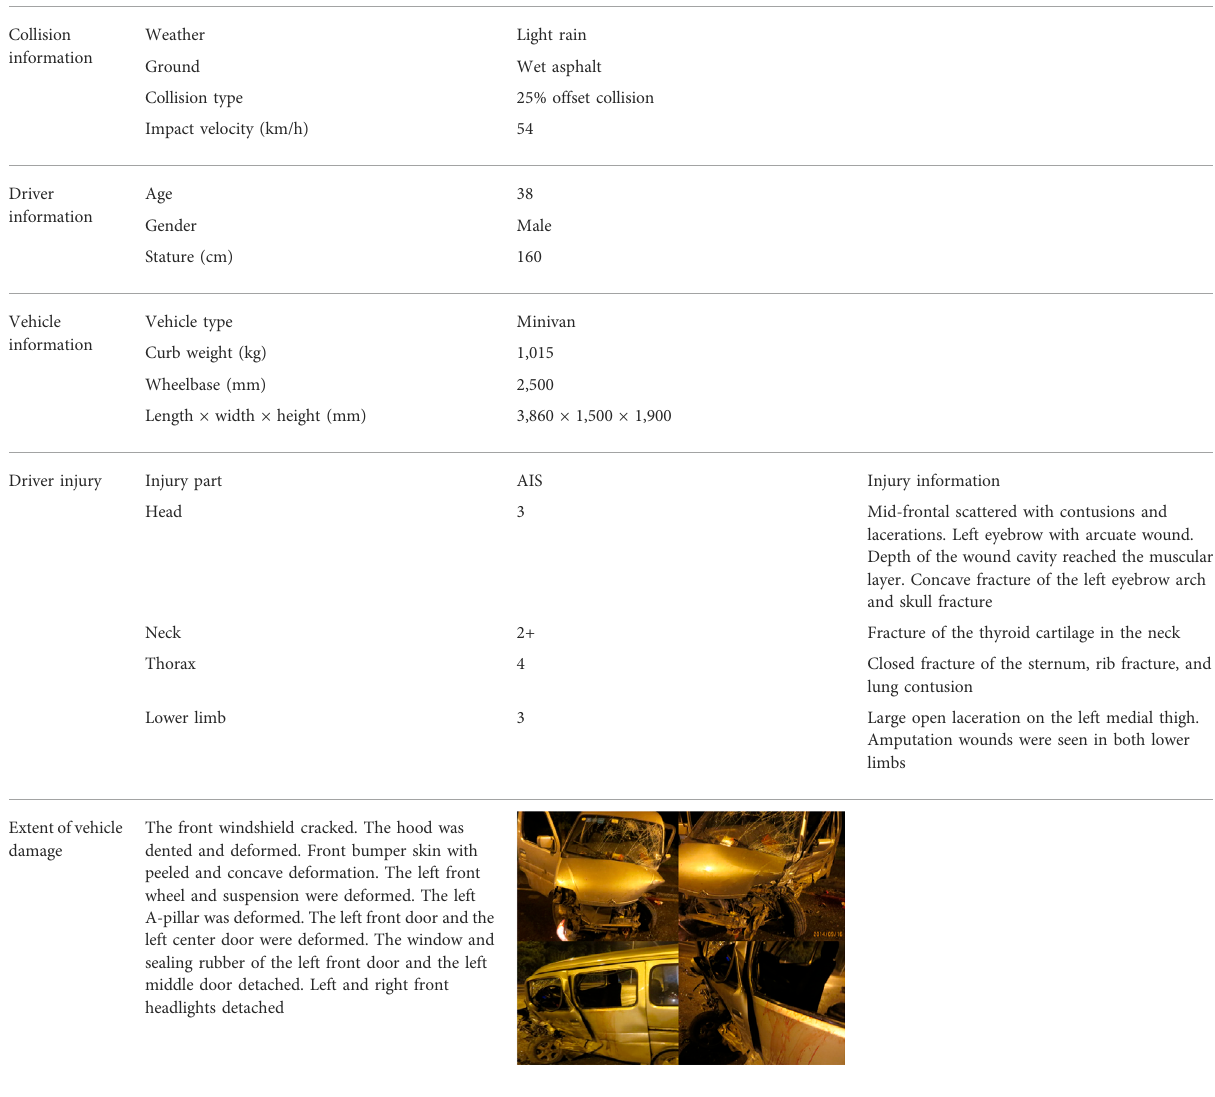
TABLE 1 Details about the collision, vehicle, and